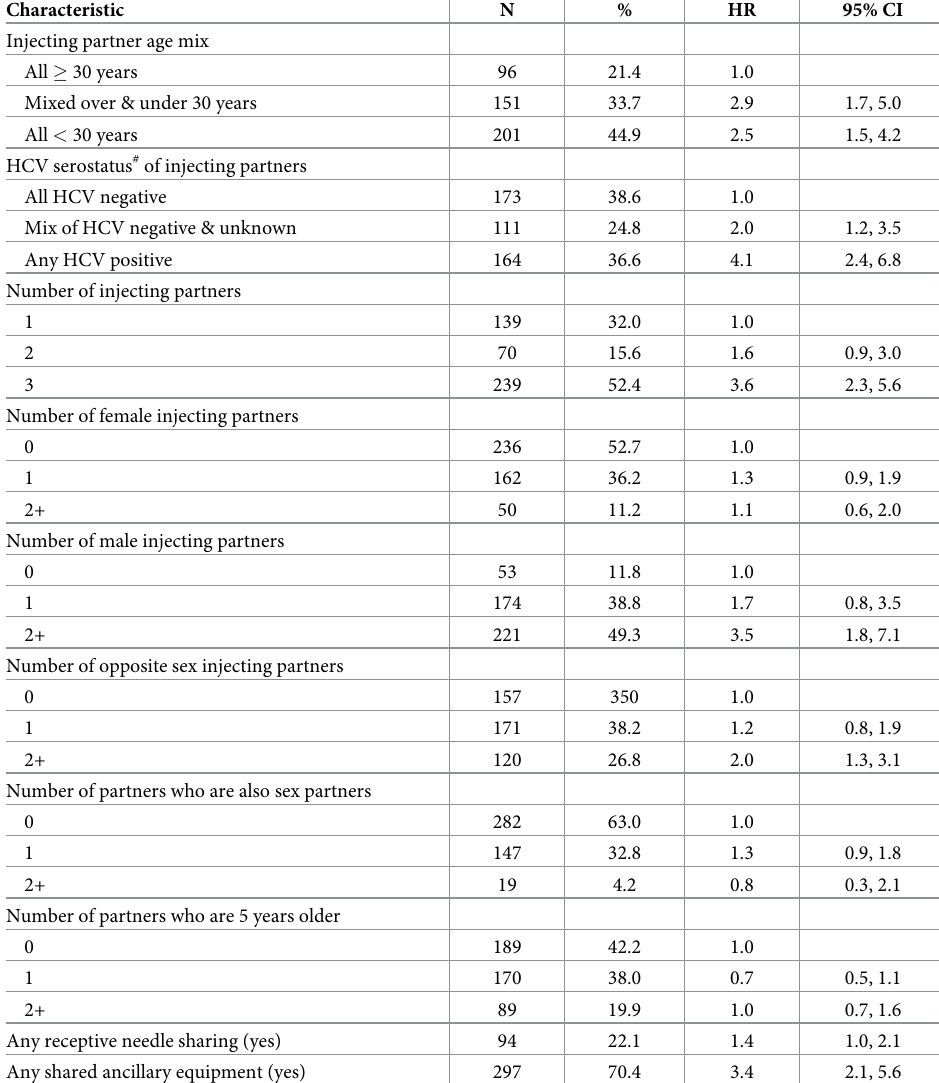
Table 2. Injecting partnership characteristics � and bivariate associations with HCV incidence.